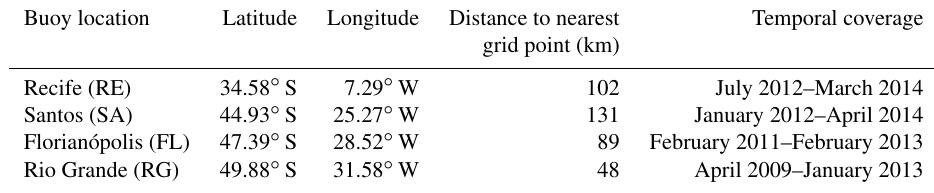
Table 1. Buoys belonging to the Brazilian National Buoys Program (PNBOIA) used to compare the interpolated series from LOS. Buoy